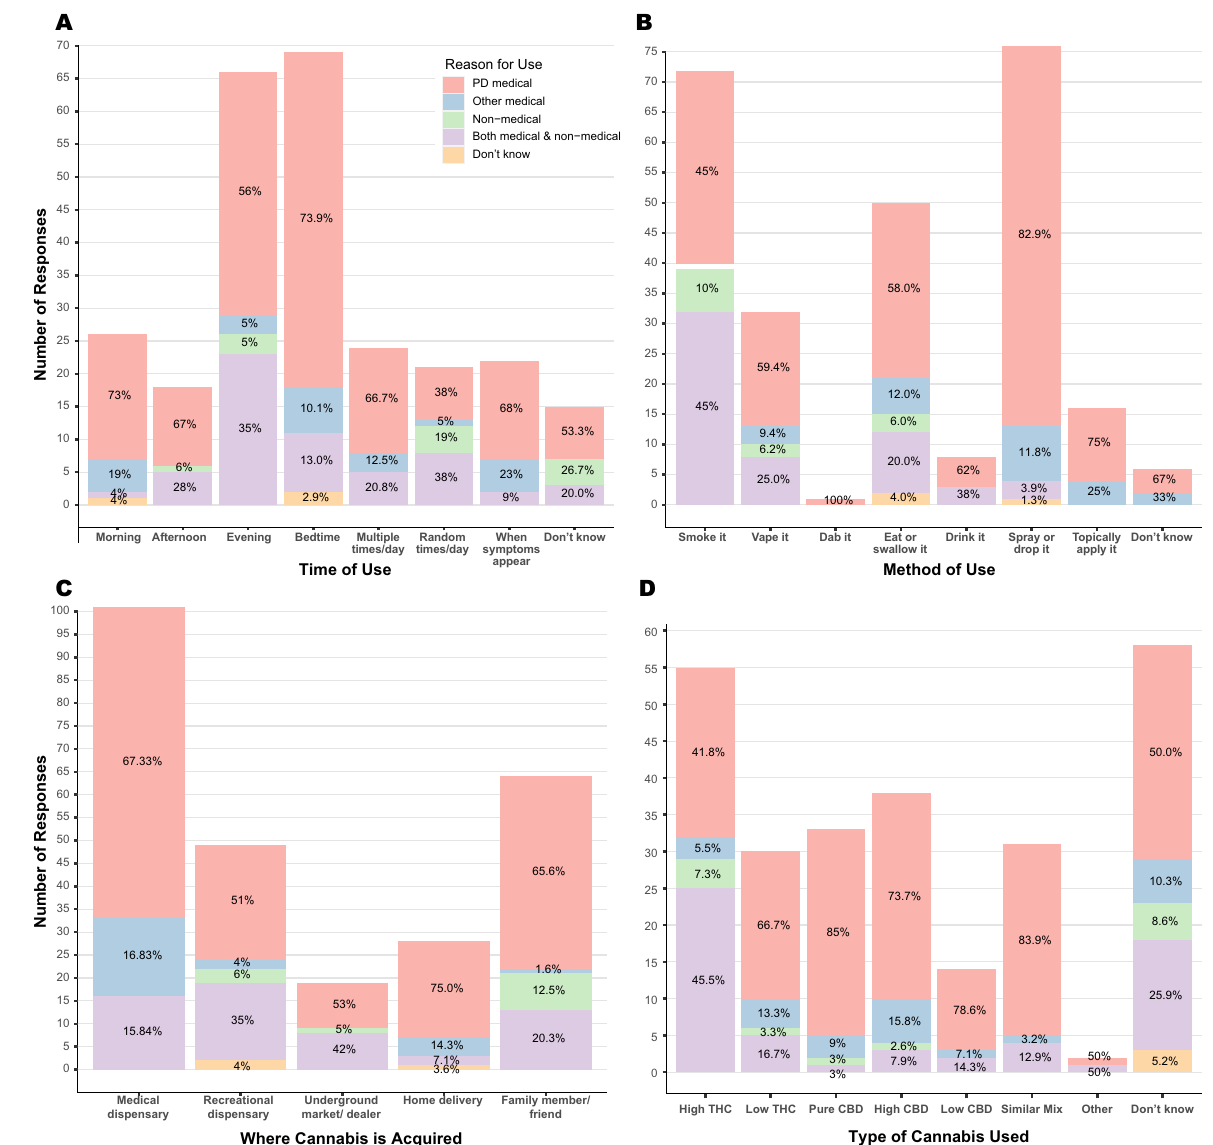
Fig. 3 Cannabis use by time of day, method, source, and type. Each cannabis user was asked ( A ) when they used cannabis during the day, ( B ) the primary method by which they used cannabis, ( C ) where they most often acquired their supply of cannabis, and ( D ) the type of cannabis they used based on the concentration of the two main constituents: THC (tetrahydrocannabinol) and CBD (cannabinol). The results were further categorized by type of user ( n = 261 for all